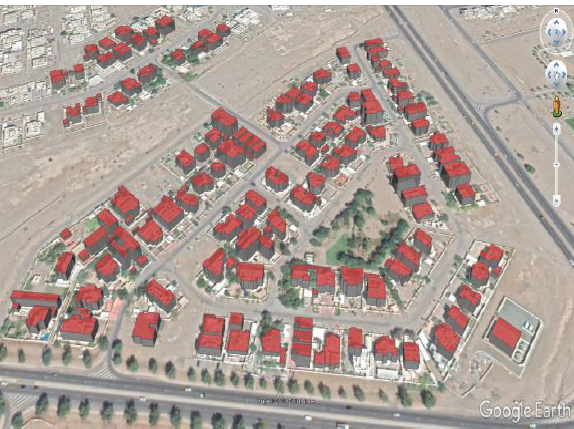
Figure 4. Part of 3DCityDB in KML